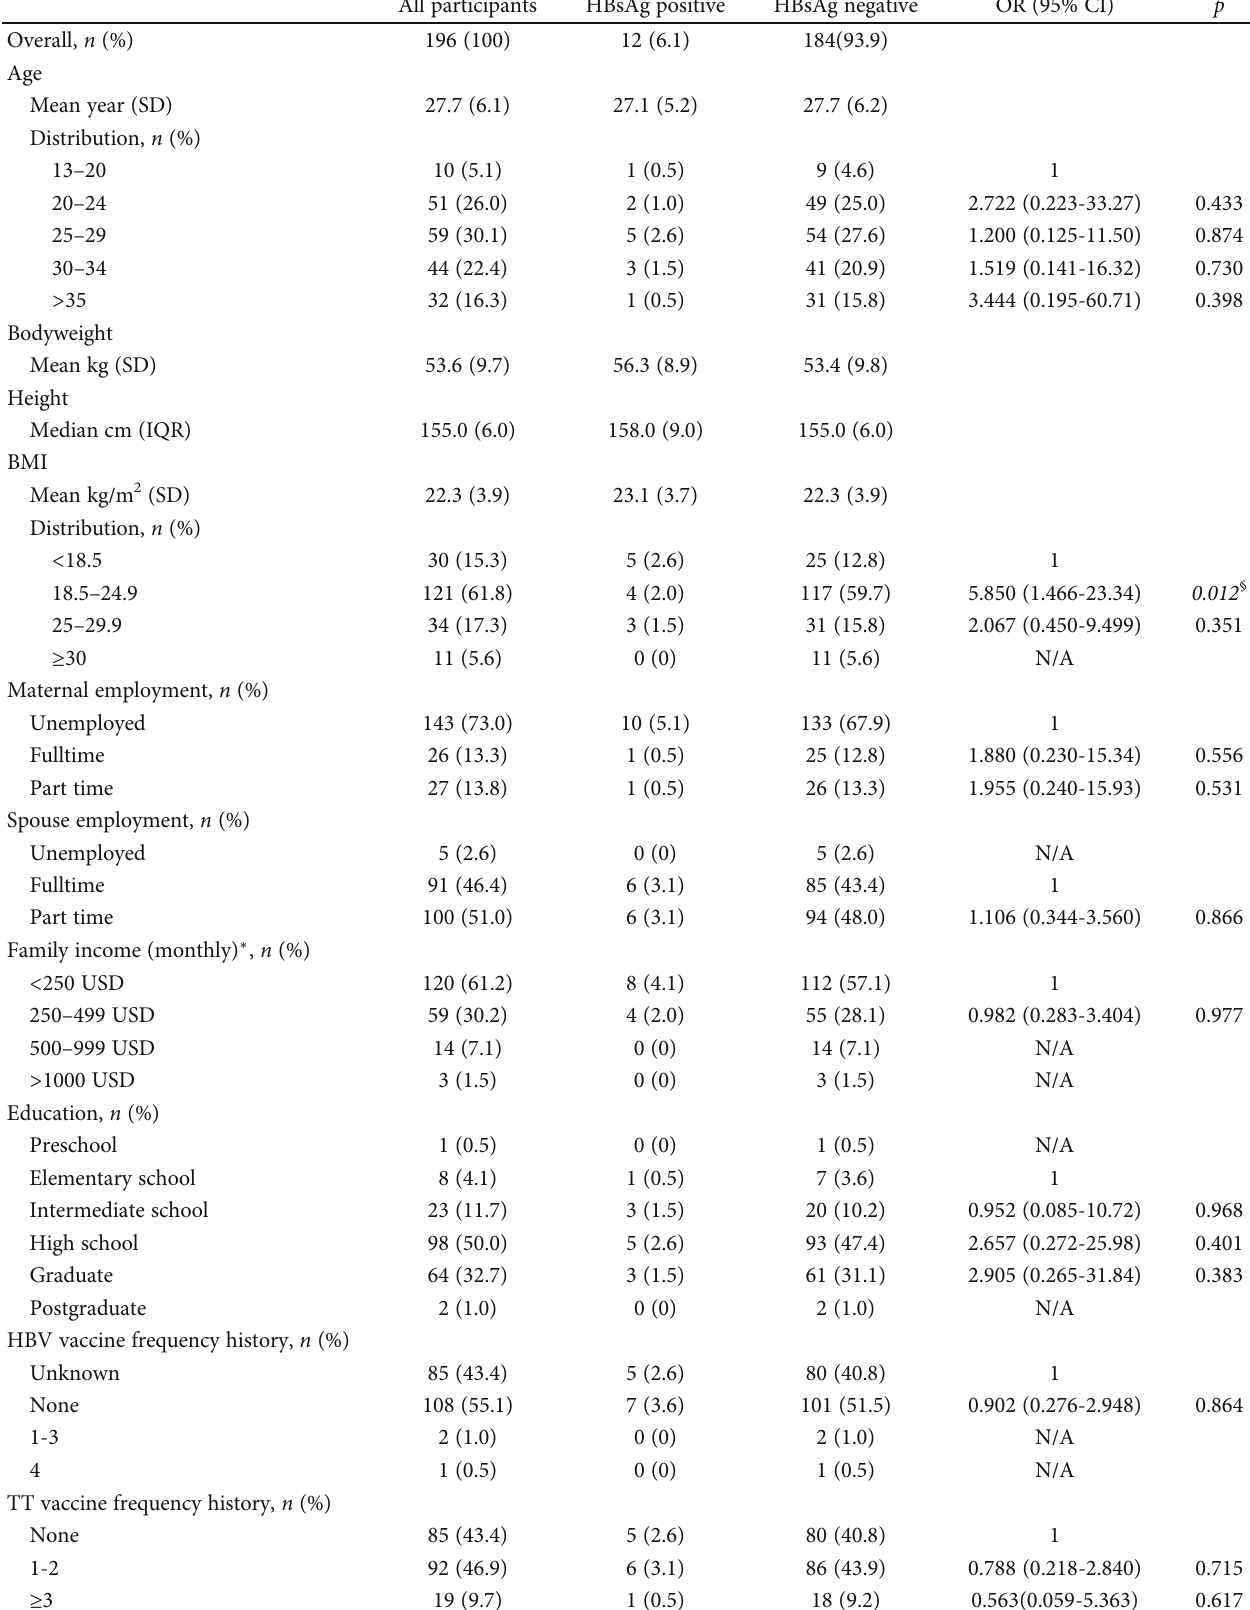
Table 1: Participant characteristics and HBsAg